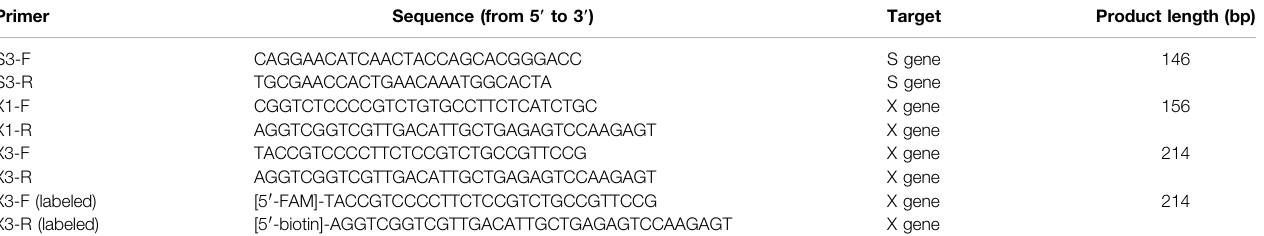
TABLE 2 | The primers used in multienzyme isothermal rapid ampli fi cation (MIRA) reaction. Primer